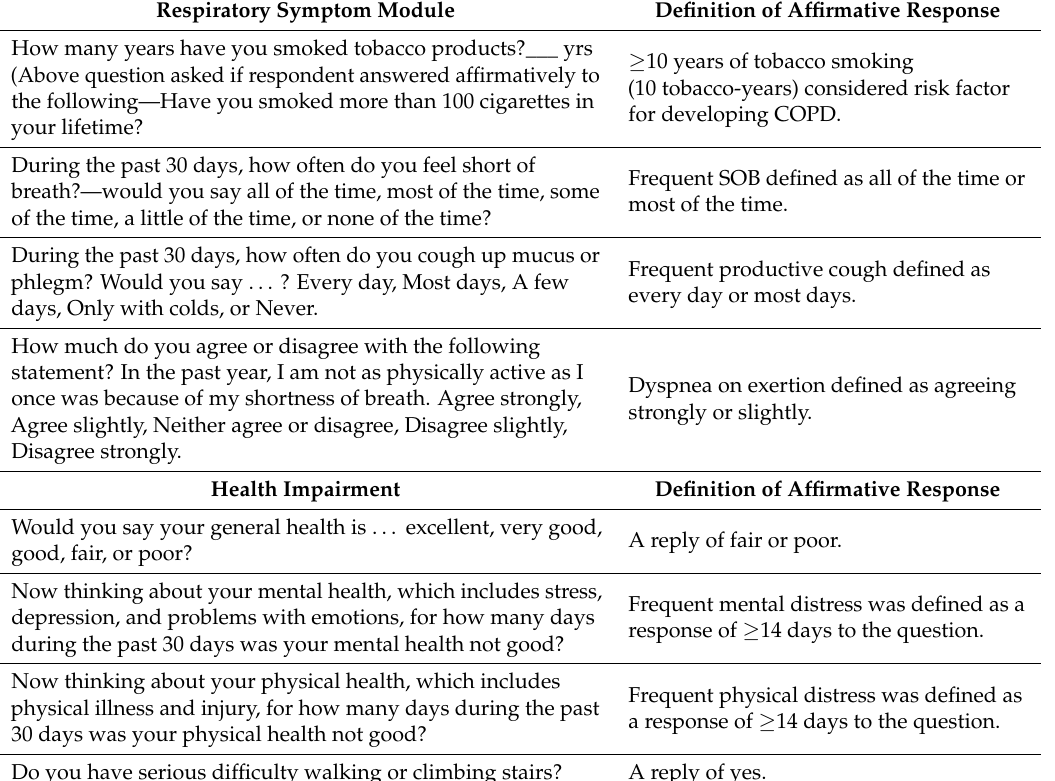
Table 1. Respiratory module and health impairment questions with possible responses using the 2015 Behavioral Risk Factor Surveillance System telephone health survey in four states (FL, KY, SC, TX). Respiratory Symptom Module Definition of Affirmative